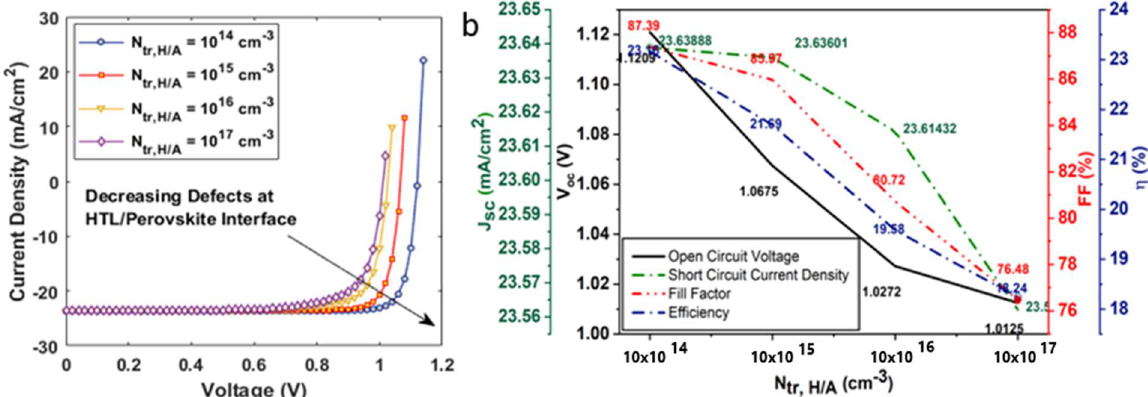
Figure 10. ( a ) Current voltage characteristics of solar on inclusion of interface defects at hole transport layer/absorber layer; ( b ) influence of interface defects on open-circuit voltage, short-circuit current density, fill factor and efficiency of the solar cell.